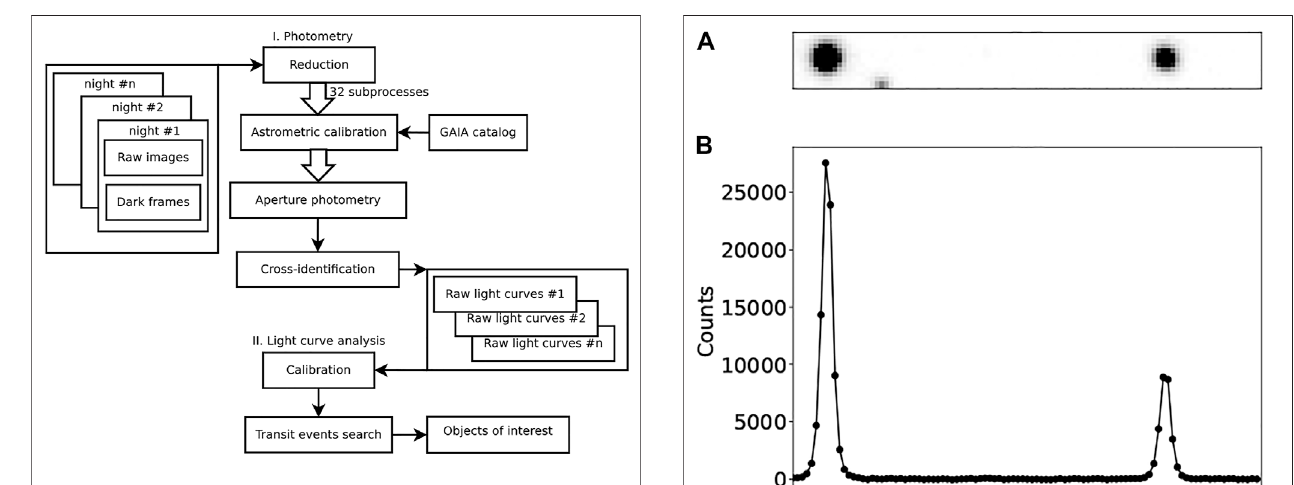
FIGURE 3 | Flowchart of the data processing algorithm for detecting exoplanets using the transit method.